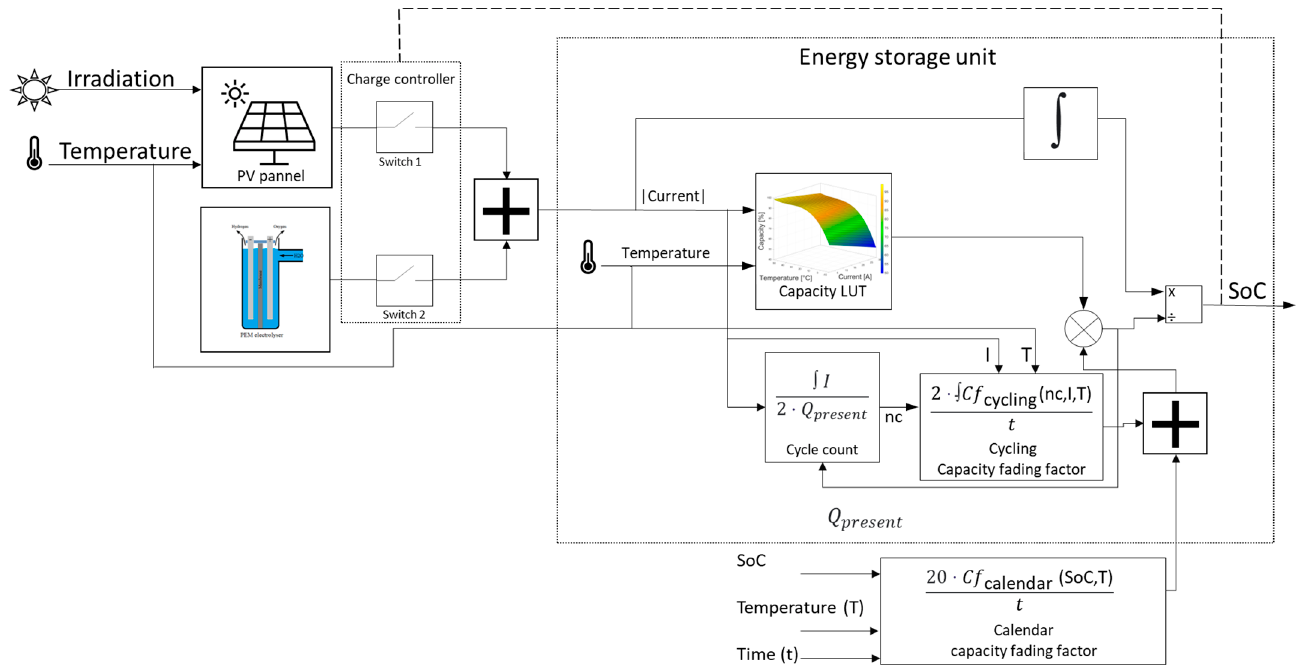
Figure 8. Green hydrogen production from the PV system model for simulation.